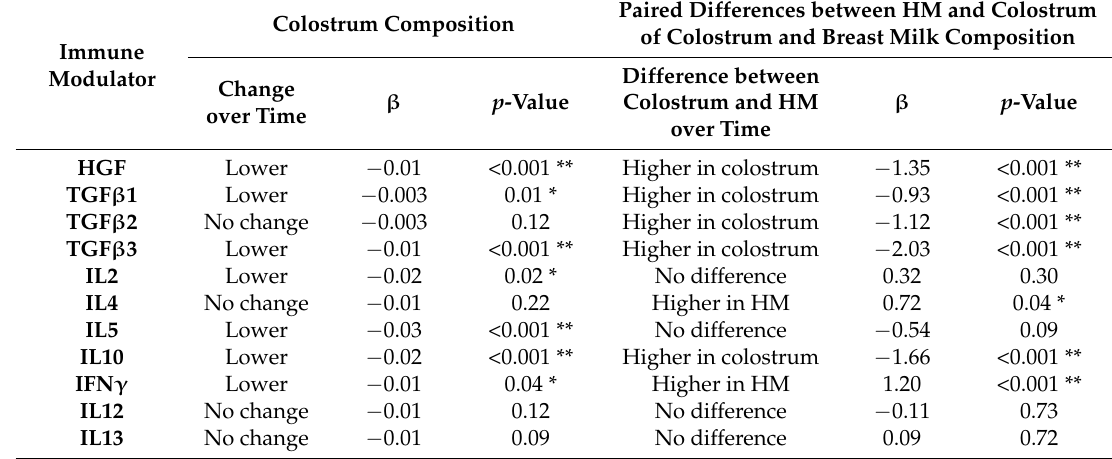
Table 2. Relationship between time of sample collection and milk